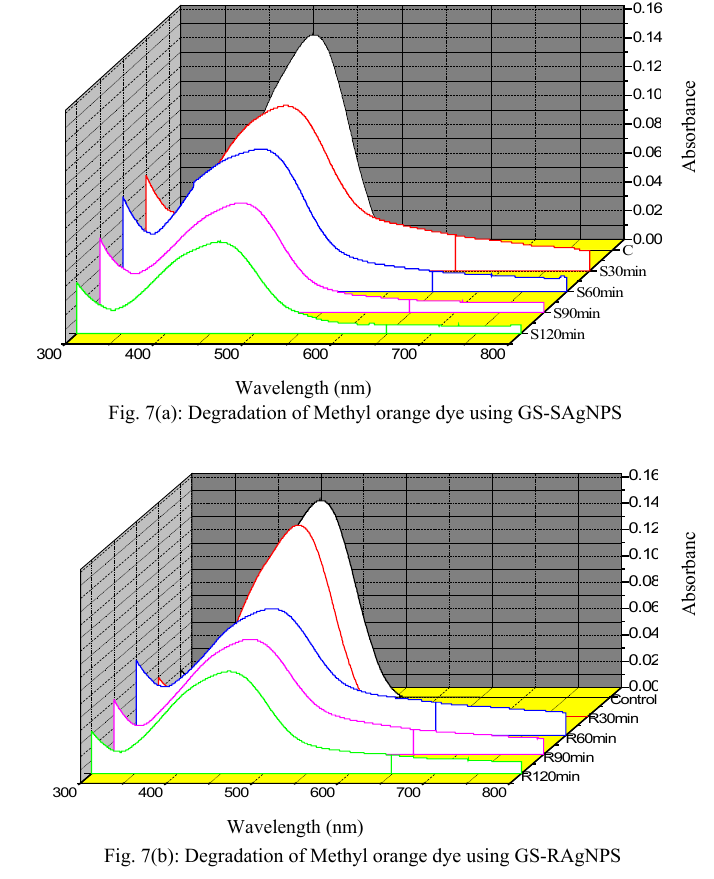
Fig. 7(b): Degradation of Methyl orange dye using GS-RAgNPS